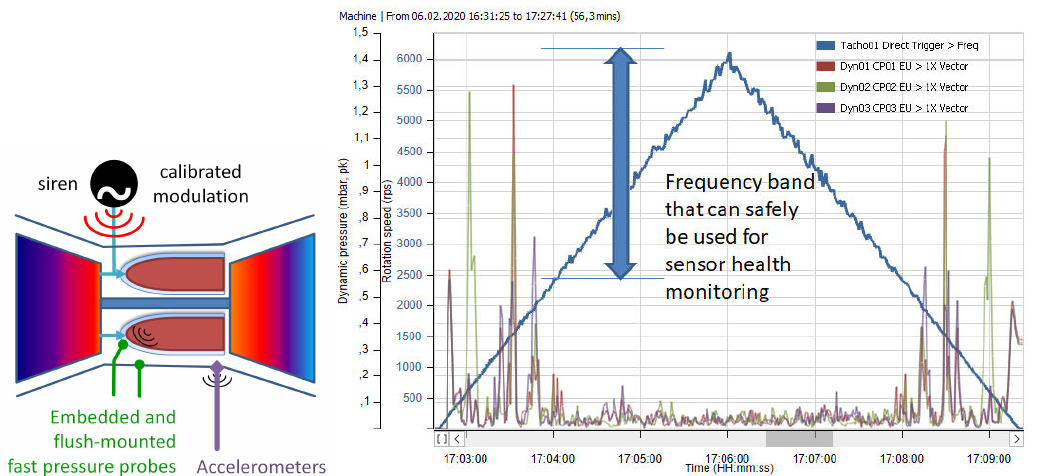
Figure 17. Health diagnostic of the GT’s dynamic sensors during operation. ( Left ): Arrangement. ( Right ): Suggested hi-frequency excitation over the 0-6k Hz range, outside of the bands where acoustic couplings are observed.